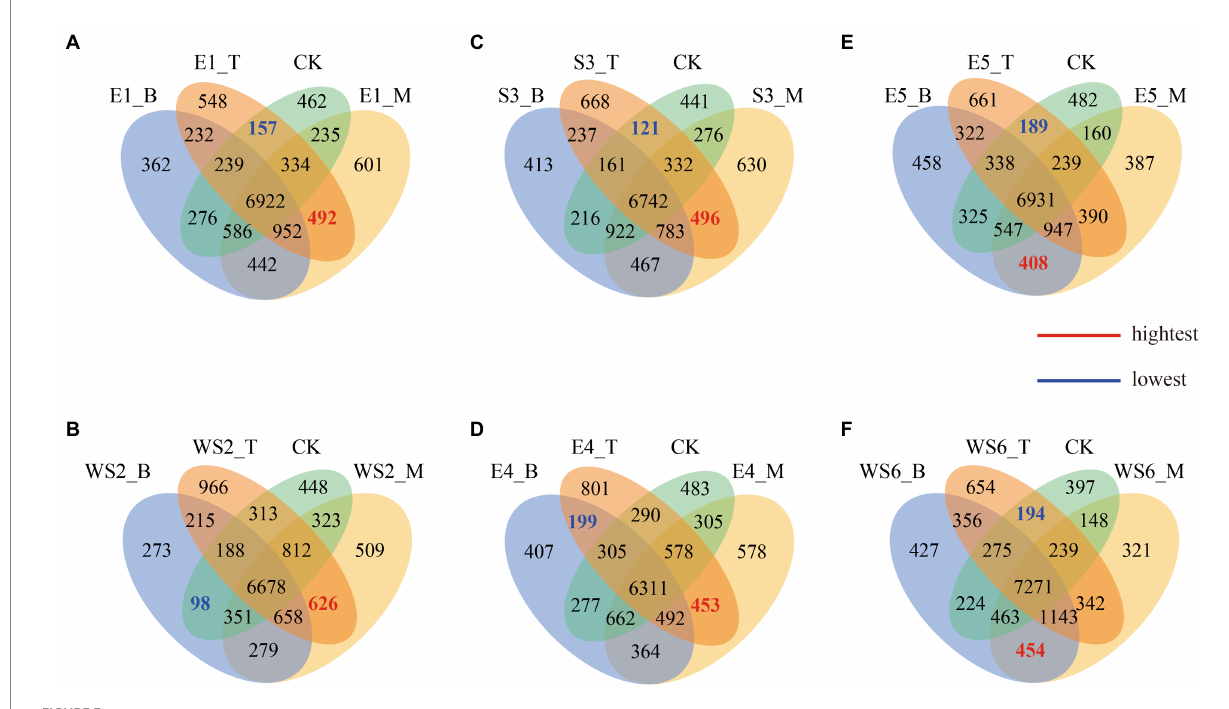
FIGURE 3 Venn diagram showing exclusive and shared OTUs of different slope